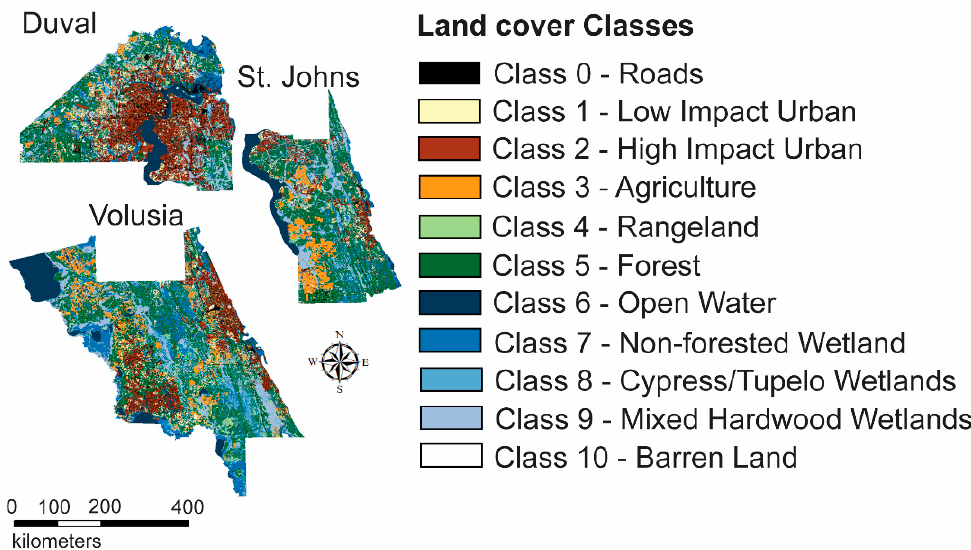
Figure 2. Aggregated land cover classes across each county in the study area.